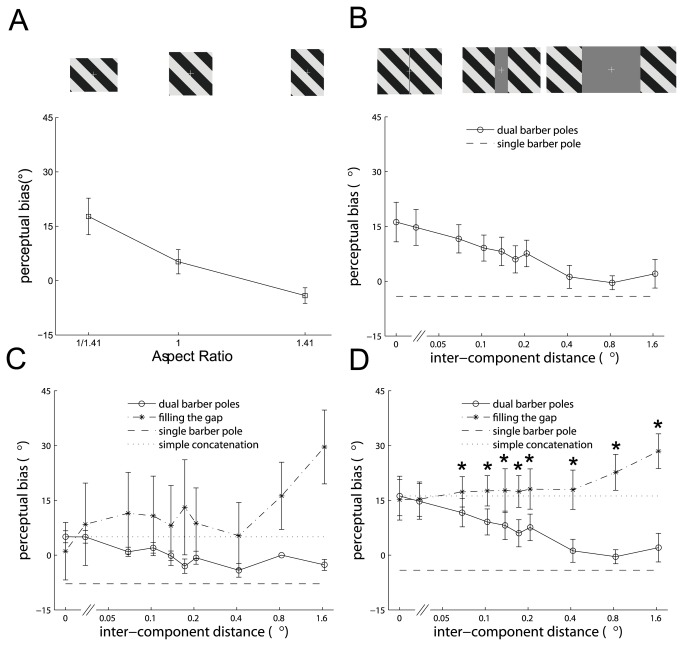
The perceived directions of single and dual barber poles and the predictions of the perceived directions of the dual barber poles based on the filling-the-gap and simple concatenation hypotheses.A. The mean perceptual bias toward the horizontal direction as a function of the aspect ratio induced by single barber poles illustrated in Figure 1A–C. The three barber poles with aspect ratios (height/width) of 1:1.41 (1°/1.41°), 1:1 (1.19°/1.19°), and 1.41:1 (1.41°/1°) are illustrated in the upper panel. The error bars indicate standard error of mean. B The mean perceptual bias toward the horizontal direction induced by the dual barber poles as a function of inter-component distance. Examples of the dual barber poles with inter-component distances of 0.03°, 0.41°, and 1.66° are illustrated in the upper panel. The perceptual bias to dual barber poles (circle trace) peaked when the inter-component distance was zero (yielding a single horizontal barber pole) and, as the inter-component distance increased, gradually decreased to approach the perceived direction of the single component barber pole. The dashed line indicates the perceptual bias induced by the single component barber pole (with an aspect ratio of 1.41:1) shown in (A). C–D. The perceptual bias to the dual barber poles at various inter-component distances (circle trace), the predictions made by the filling-the-gap (star trace) and simple concatenation hypotheses (dotted line), and the perceptual bias induced by the single component barber pole (dashed line), observed in an example subject (C) and in the mean across subjects (D) (* symbols indicate significant difference between the dual barber pole and completed barber pole, p < 0.05 using repeated-measures ANOVA).